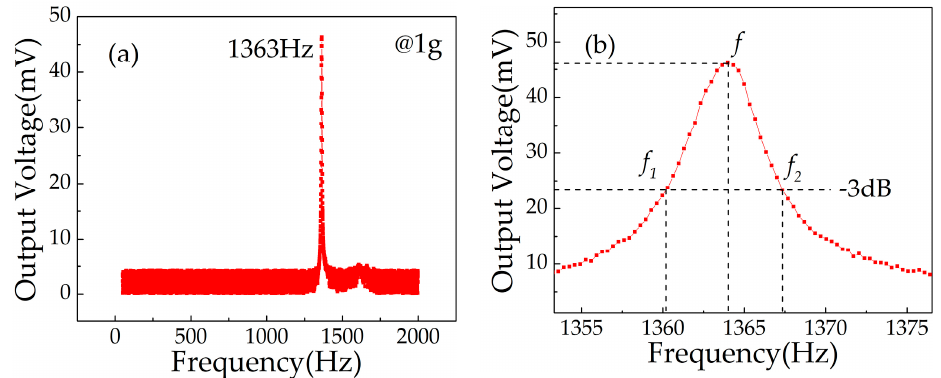
Figure 12. Relationship curve between output voltage and excitation frequency: ( a ) resonant frequency; ( b ) quality factor.